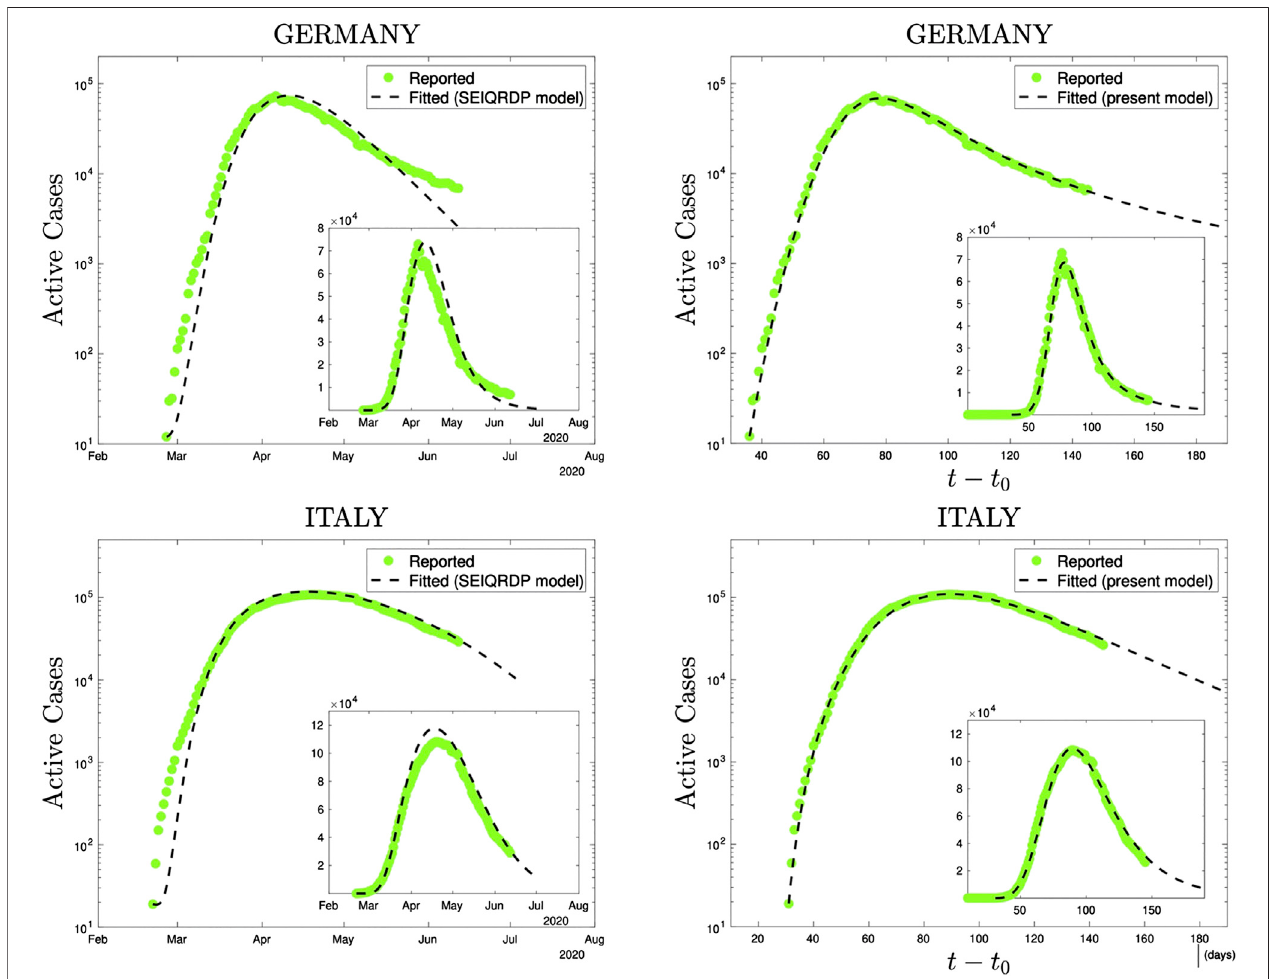
FIGURE 5 | Comparison, using precisely the same reported data (green dots), of the SEIQRDP model (left plots) and the q -SEIR model (right plots) for the time series of Germany (from February 26 th to June 13 th 2020) and of Italy (from February 21 st to June 13 th 2020). To obtain the SEIQRDP fi ttings (seven linear/bilinear equations satisfying S + E + I + Q + R + D + P (cid:2) N and including several fi xed as well as two time-dependent coef fi cients), we have used the online program [47]. To obtain the q -SEIR fi ttings (four not necessarily linear/bilinear equations satisfying S + E + I + R (cid:2) N eff and including only fi xed parameters, two of them being the nonlinear exponents q up and q down ), we have used a Standard Least Squares Method (linear scales).